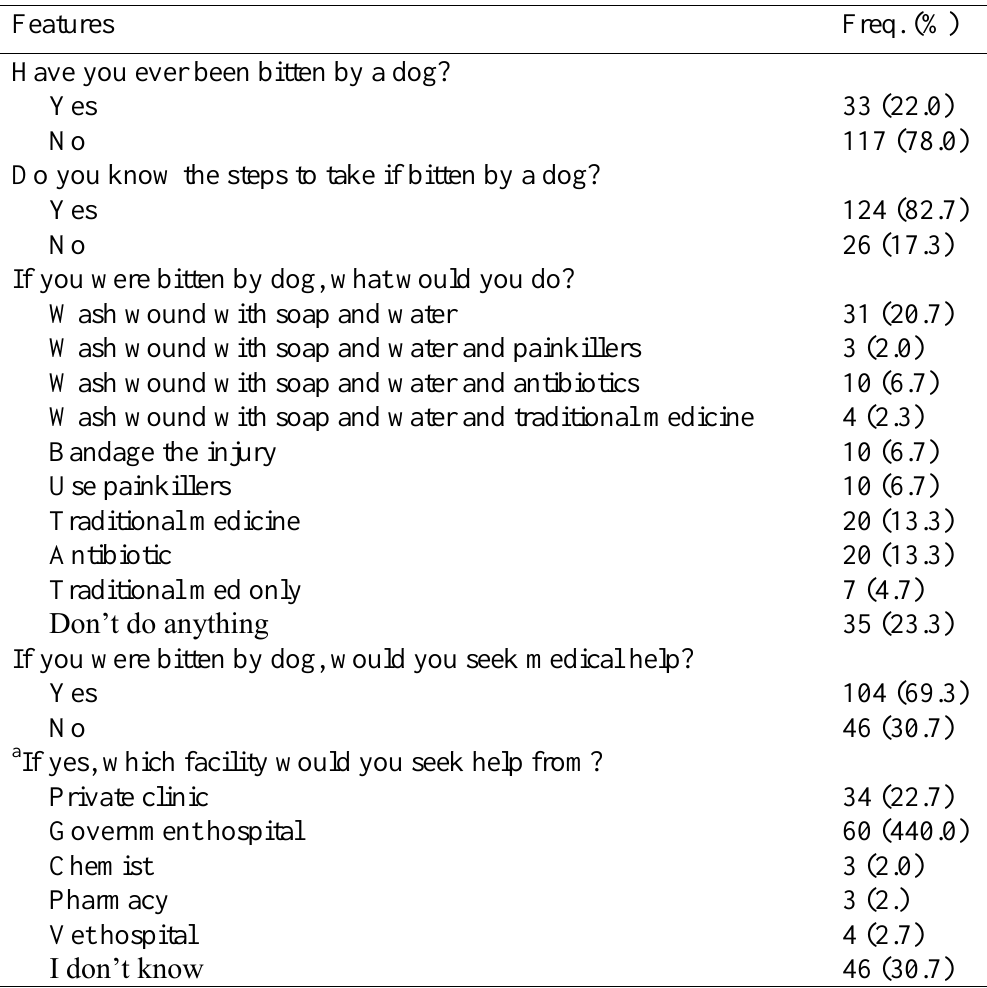
Table 4: Attitude of dog owners towards dog